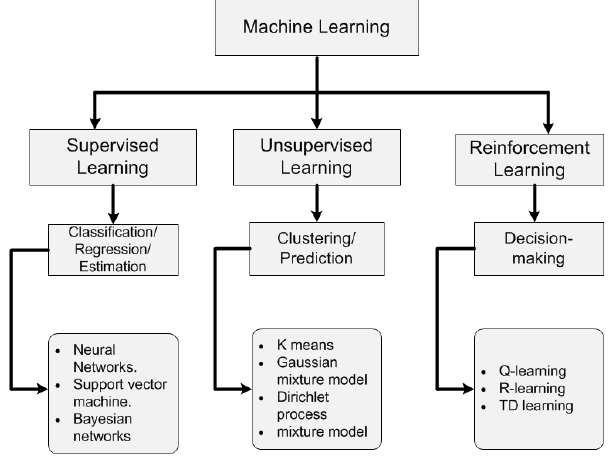
Figure 6. Comparison of different types of machine